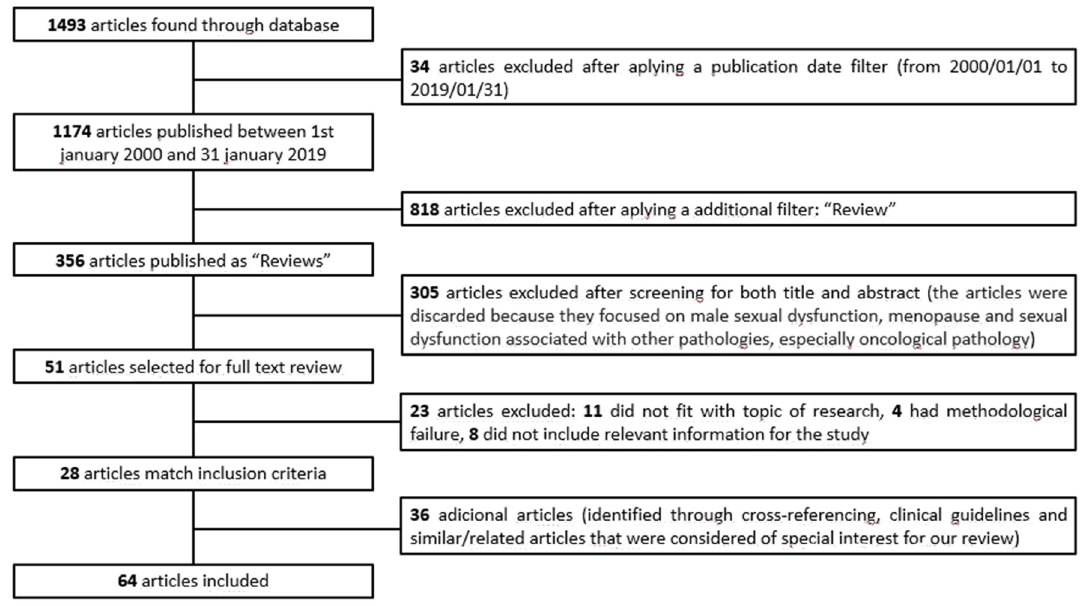
Figure 1. PRISMA flow diagram. (Preferred Reporting Items for Systematic Reviews and Meta-Analyses).